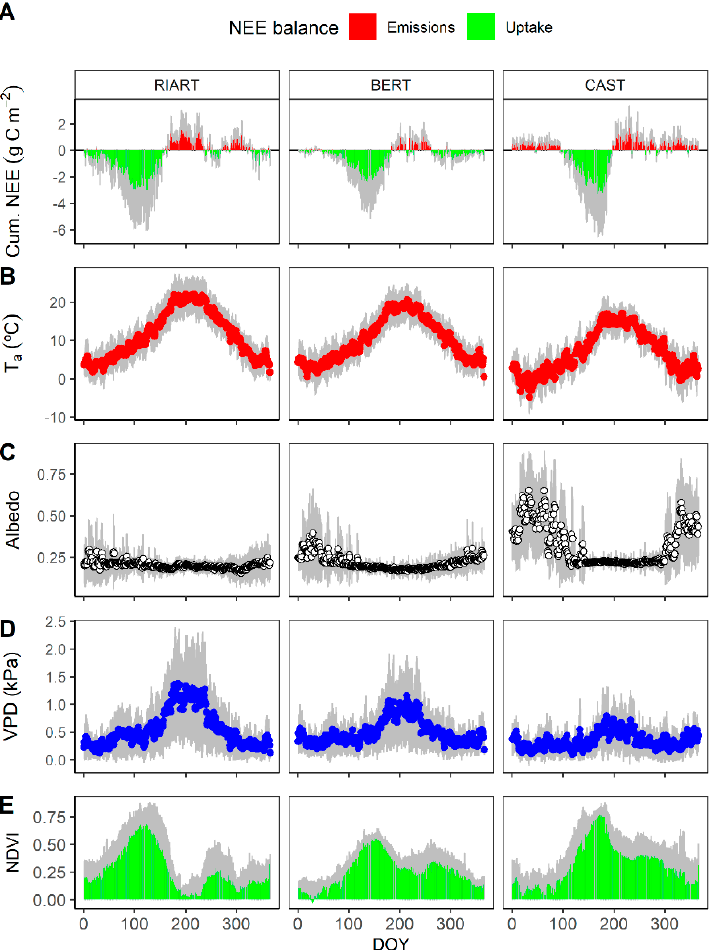
Figure 5. Intra-annual dynamics, mean daily averaged ± 1 SD (grey area) of ( A ): cumulative net ecosystem exchange (NEE); ( B ) air temperature (T a ); ( C ) albedo; ( D ) vapor pressure deficit (VPD); ( E ) and normalized vegetation index (NDVI). Source: eddy covariance flux stations.